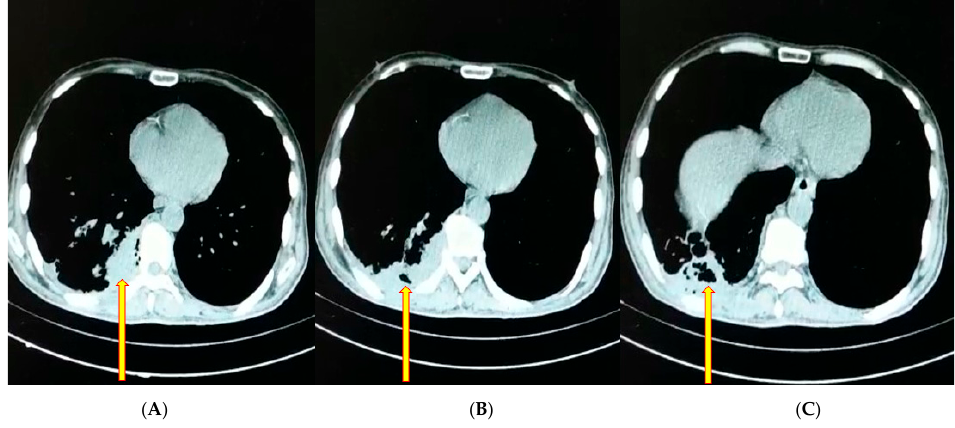
Figure 2. Computed tomography of the chest. ( A ) Axial computed tomography (CT) in a 51-year-old man showing right lower lobe nodules and opacities, bilaterally. ( B , C ) CT images showing necrotizing pneumonia with air picture within the pulmonary infiltrate, indicated by arrows. These features are relevant to a necrotic lung fragment in the angio-invasive form of pulmonary aspergillosis and co-morbid COVID-19 (CAPA), pulmonary tuberculosis, and type 2 diabetes mellitus with moderate diabetic ketoacidosis. Blood gas analysis revealed pH = 7.08, PaO 2 = 74, PaCO 2 = 17, HCO 3 = 5.3, and lactate = 84 mm, the criteria for moderated DKA. Laboratory findings on the day of admission